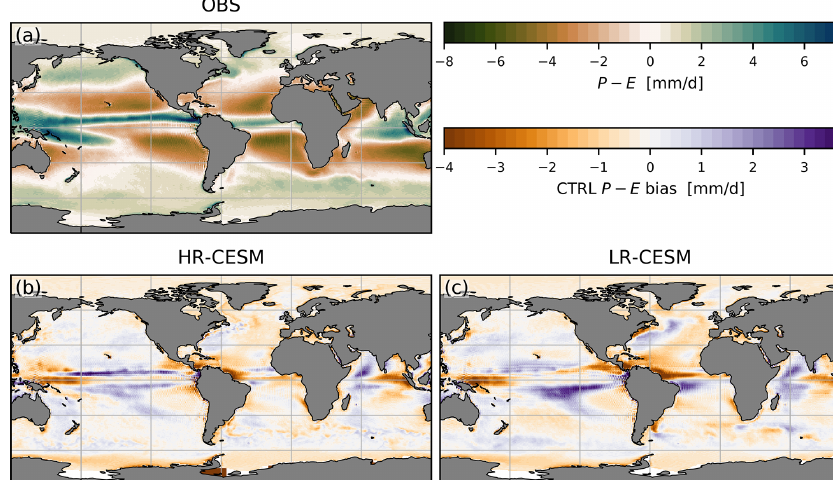
Figure A2. Comparing HR-CESM (a, b) and LR-CESM (c) precipitation to ERA-Interim, like Fig. 2.